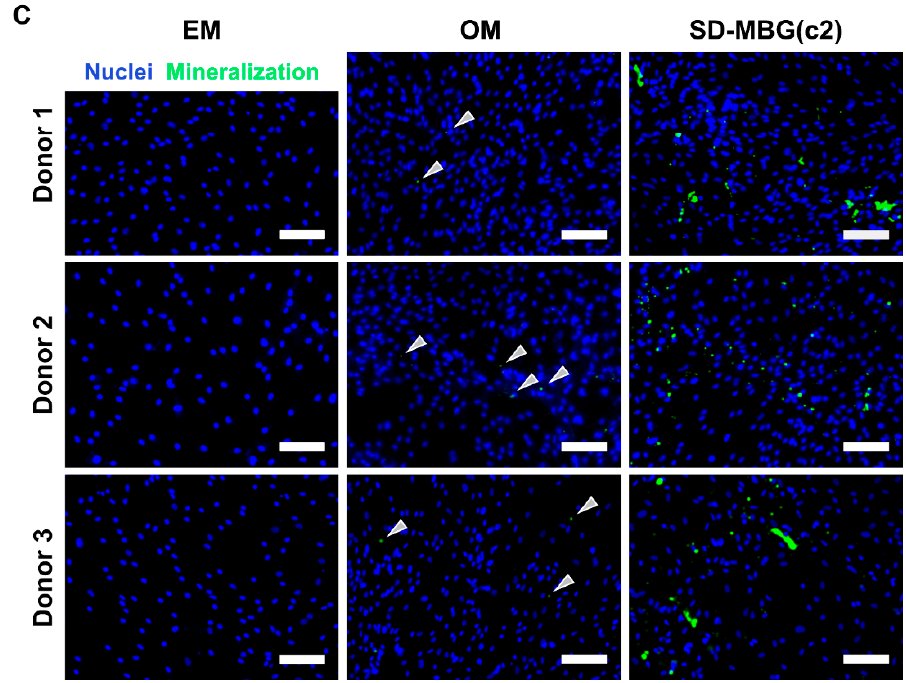
Figure 4. Matrix mineralization and free phosphate accumulation in supernatant of hMSCs upon osteogenic induction and continuous exposure to SD-MBG dissolution products over 14 days. ( A ) Osteogenic di ff erentiation induction in hMSCs by culture in osteogenic medium (OM) and exposure to SD-MBG ionic extracts in OM. Relative matrix mineralization depicted as alizarin red (AR) optical density over cell count (DAPI signal), normalization to cells cultured in expansion medium (EM) (negative control). Matrix mineralization can be observed in all groups receiving OM (OM, concentration 1 (c1) = 1.5 mg / mL SD-MBGs and concentration 2 (c2) = 5 mg / mL SD-MBGs), with SD-MBG in c2 inducing significantly higher mineralization compared to OM group; n = 3 hMSC donors with ≥ 3 technical replicates each. One-way ANOVA with Dunnetts’s multiple comparison test was performed using OM as comparator. ( B ) Quantification of free phosphate accumulation in supernatant over time. In all groups receiving OM, an increase in phosphate amount can be observed starting at day six. n = three hMSC donors with three technical replicates. ( C ) At day 14 of osteogenic induction, OsteoImage staining (green) combined with nuclei staining (DAPI, blue) was conducted, imaged at 10 × , scale bar = 100 µ m. Representative images are shown for n = three hMSC donors. Arrows in the OM group point at mineralized nodules. Note the substantially increased matrix mineralization for the SD-MBG group, here shown as representative images from c2. p -values for statistical significance were * p < 0.05.